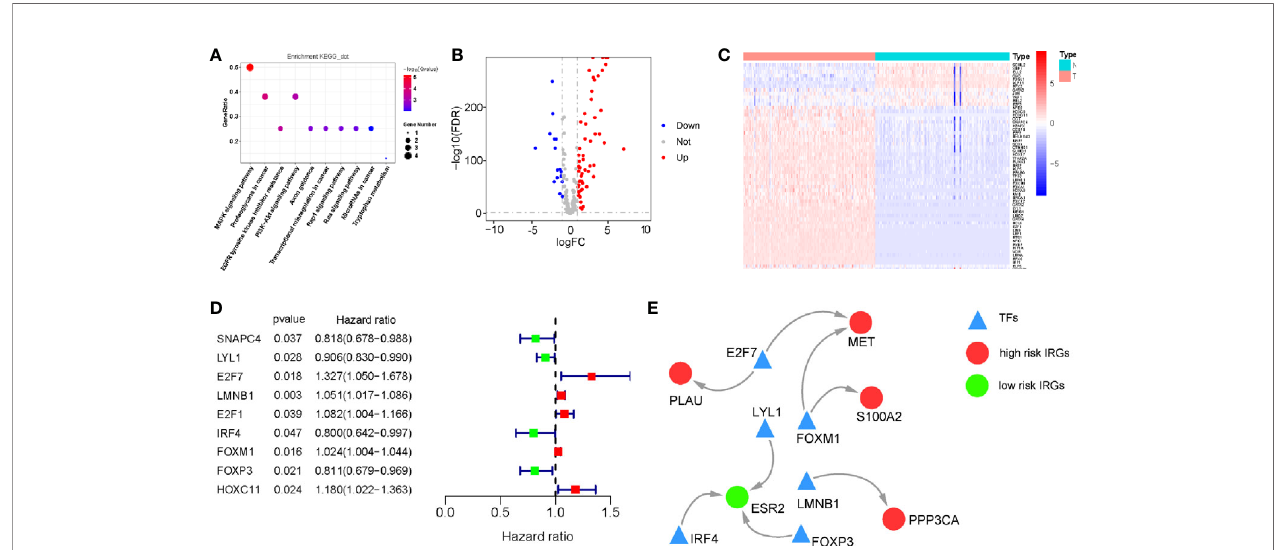
FIGURE 4 | Regulatory network of survival-associated immune-related genes (IRGs). (A) Kyoto Encyclopedia of Genes and Genomes (KEGG) analysis (only show signaling pathway, P < 0.05). (B) Volcano plot demonstrating differentially expressed transcription factors (TFs) between pancreatic ductal adenocarcinoma (PDAC) and normal pancreatic tissues, Red dots represent genes with a higher level of expression in PDAC, whereas blue dots represent lower expression. (C) Heatmap showing the expression of TFs in each sample. (D) The hazard ratio and 95% con fi dence interval of survival-associated TFs using Cox proportional-hazards regression analysis. (E) Regulatory network constructed based on clinically relevant TFs and